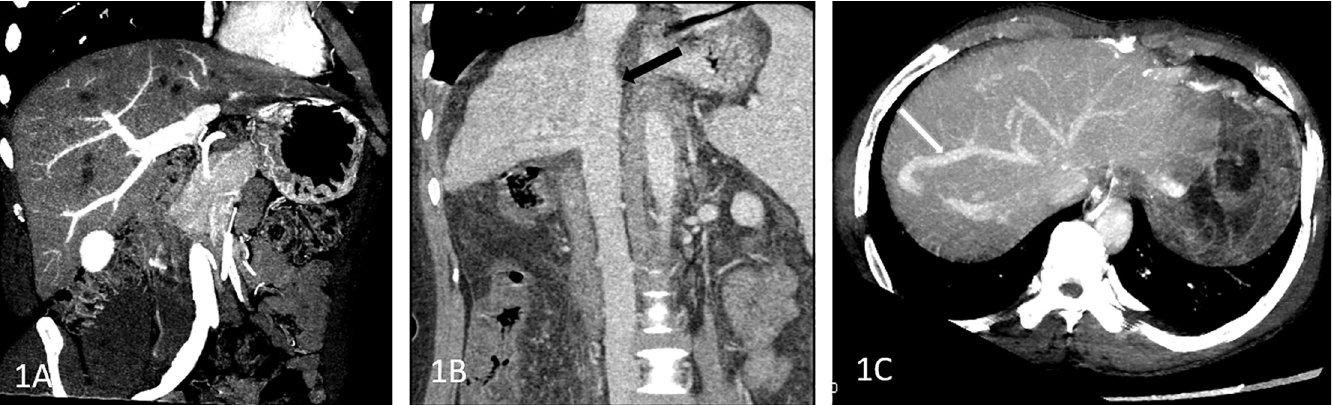
Fig 1. Vascular reconstruction of PV, HV, and IVC. A maximum intensity projection (MIP) image of the PV, showing the PV trunk and its branches clearly; Fig 1B curve planar reformation (CPR) image of the IVC, showing the IVC patency (black arrow); Fig 1C maximum intensity projection(MIP) image of the HV, showing the left HV, HV and right HV occlusion, subhepatic vein open, through the auxiliary hepatic vein (white arrow) into IVC.